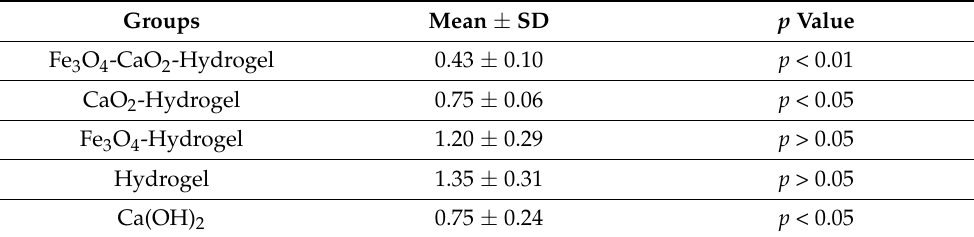
Table 2. Specific data of each group of radiolucent